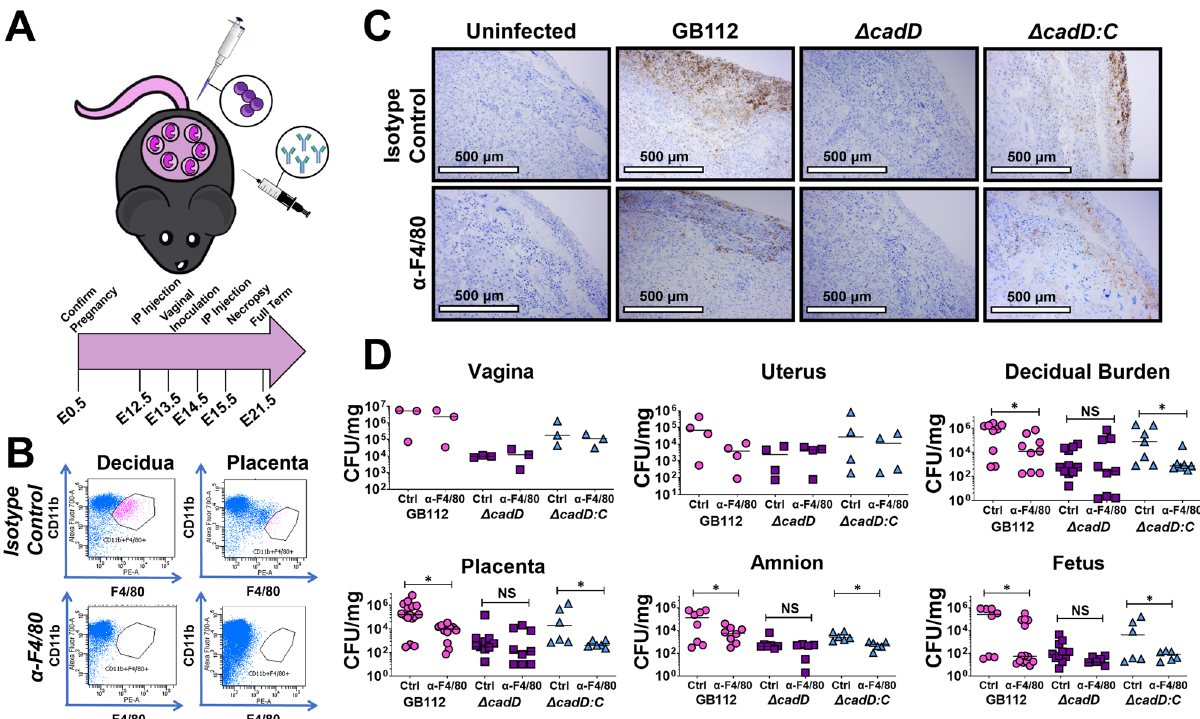
Fig.6|DepletionofhostmacrophagesalterstheoutcomeofGBSinfectionina cadD -dependent manner. A Conceptual diagram of methods utilized in these studies. Pregnant mice were intraperitoneally injected on embryonic day 12.5 and 14.5 with either anti-F4/80 antibody to deplete host macrophages, or an isotype controlantibody.MicewereinfectedwithGBSonembryonicday13.5andsacri fi